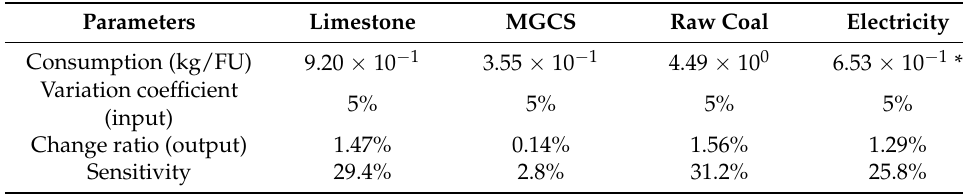
Table 4. Sensitivity analysis of the main substance inputs.